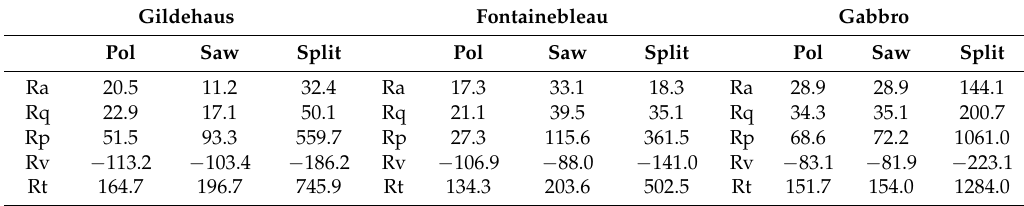
Table 5. Surface roughness parameter values in µ m.